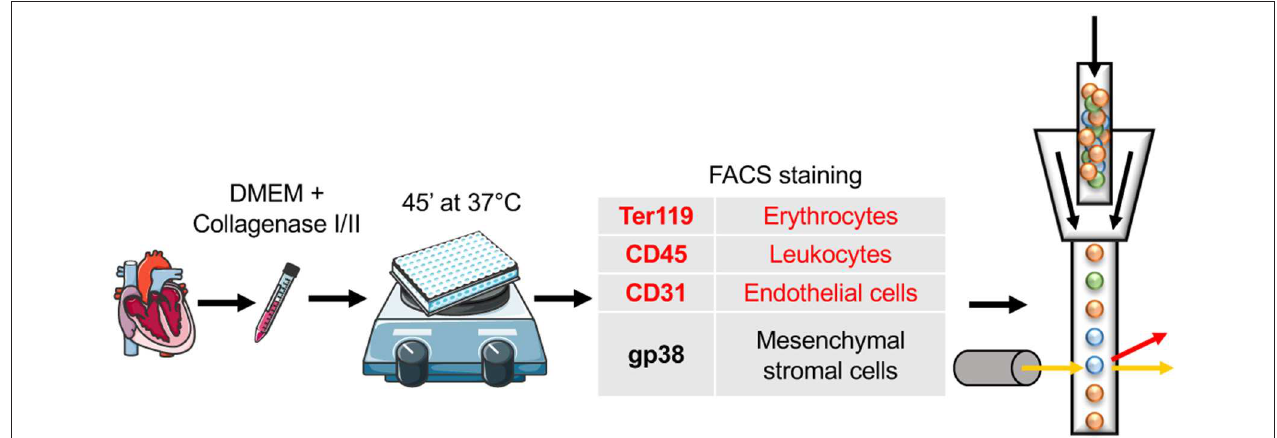
FIGURE 1 | Schematic protocol for stromal cell isolation from the mouse heart. Adult C57BL/6 mice were sacrificed and PBS perfusion via left ventricle was performed. Subsequently, hearts were cut with scissors and digested enzymatically, using pure DMEM complemented with a mixture of collagenase I, II, and DNAse. The incubation was performed for 45 ′ at 37 ◦ C in the presence of magnetic beads on a magnetic stirrer. Next, flow cytometry staining of antibodies included in the panel for stromal cell subset identification was implemented. Markers in red were used for the negative selection (Ter119, CD45, and CD31). In addition single cell suspension was evaluated for the expression of gp38 (in black). Cartoons adapted from SERVIER MEDICAL ART (https://smart.servier.com/), Creative Commons Attribution 3.0 License (https://creativecommons.org/licenses/by/3.0/legalcode).